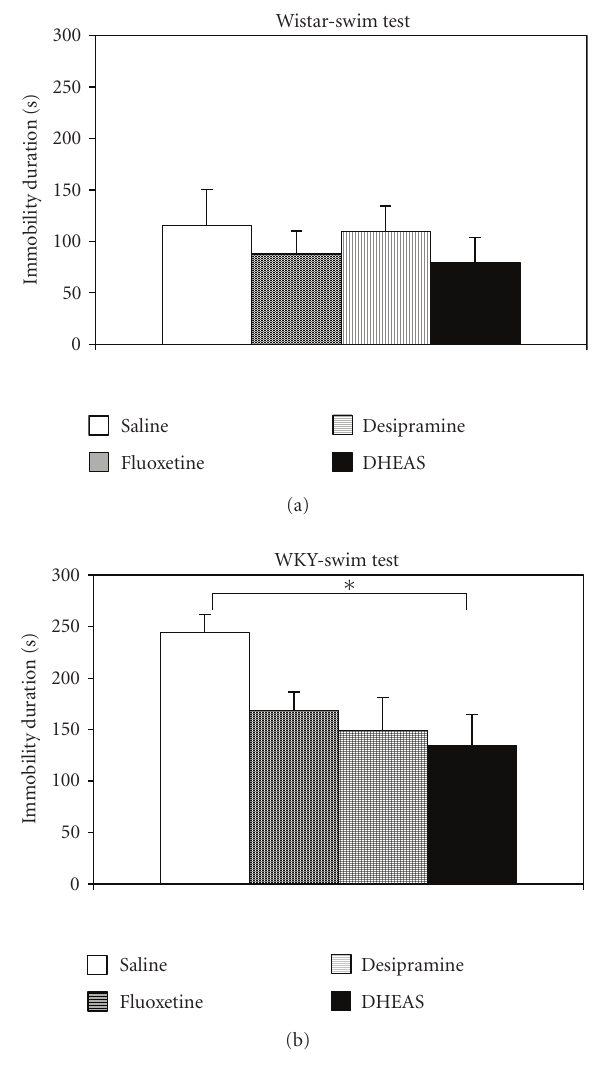
Figure 3: (a) Mean immobility duration in sec. ( ± SEM) of 35 days old Wistar rats after chronic administration of antidepressants (desipramine, fluoxetine, DHEAS) or saline ( N = 8 in each group). (b) Mean immobility duration in sec. ( ± SEM) of 35 days old WKY rats after chronic administration of antidepressants (desipramine, fluoxetine, DHEAS) or saline ( N = 8 in each group). ∗ P < .